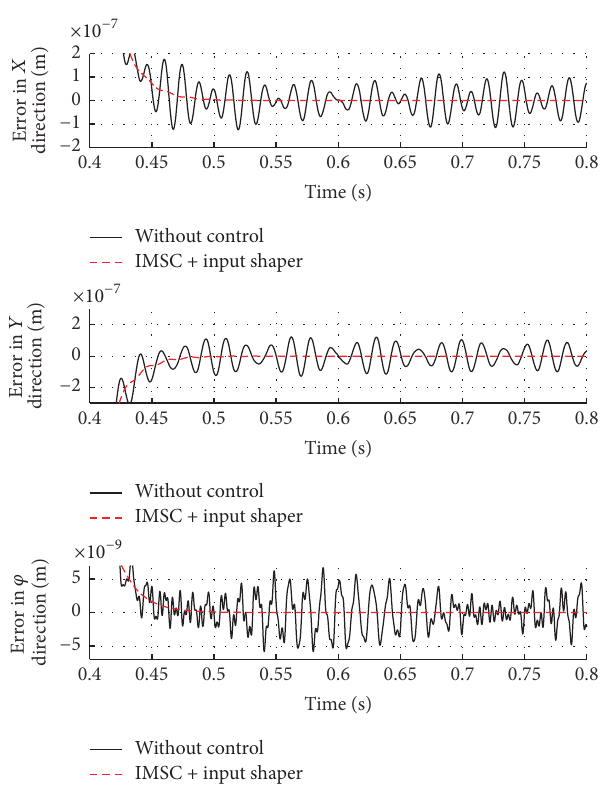
Figure 6: Amplified view of the positioning error of the rigid motion in 3 planar